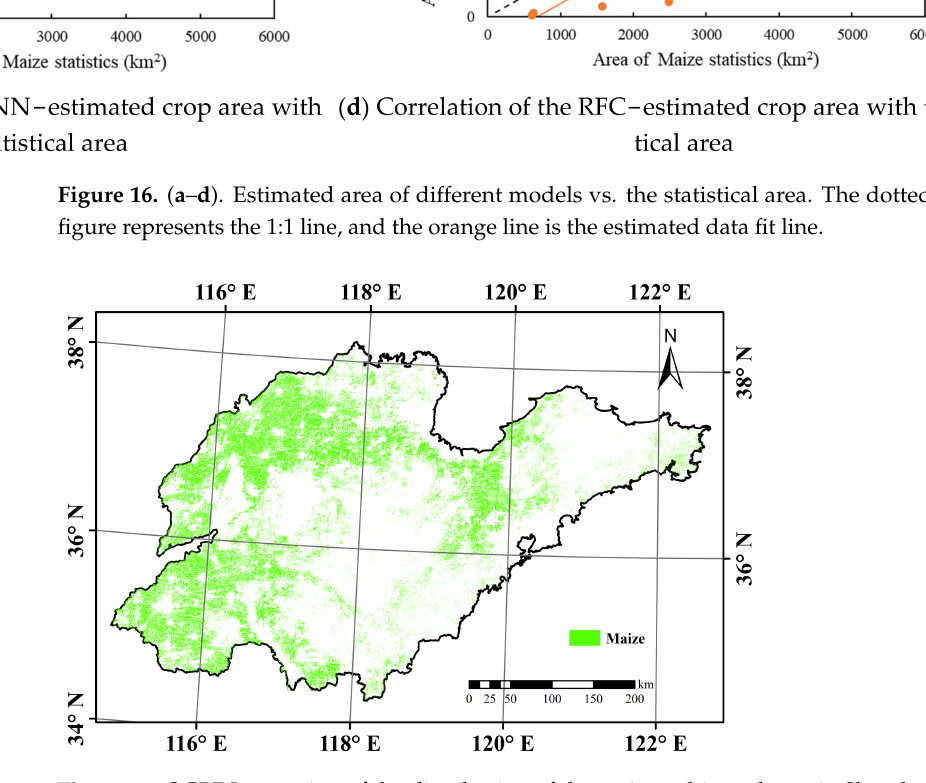
Figure 17. OCBDL mapping of the distribution of the maize cultivated area in Shandong Province in